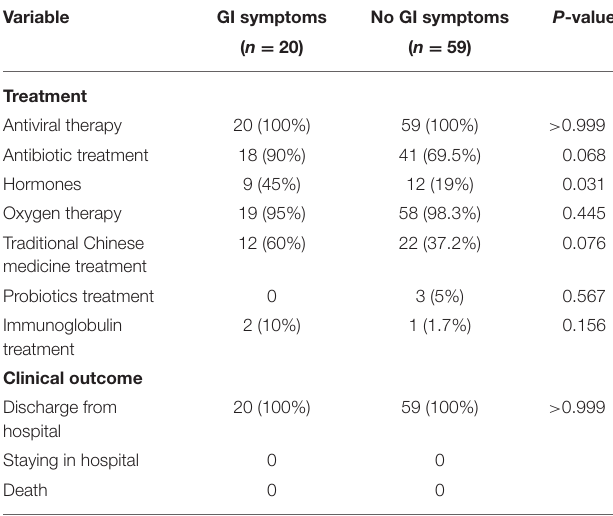
TABLE 3 | Treatment and Clinical outcome in patients with COVID-19 with and without GI symptoms.